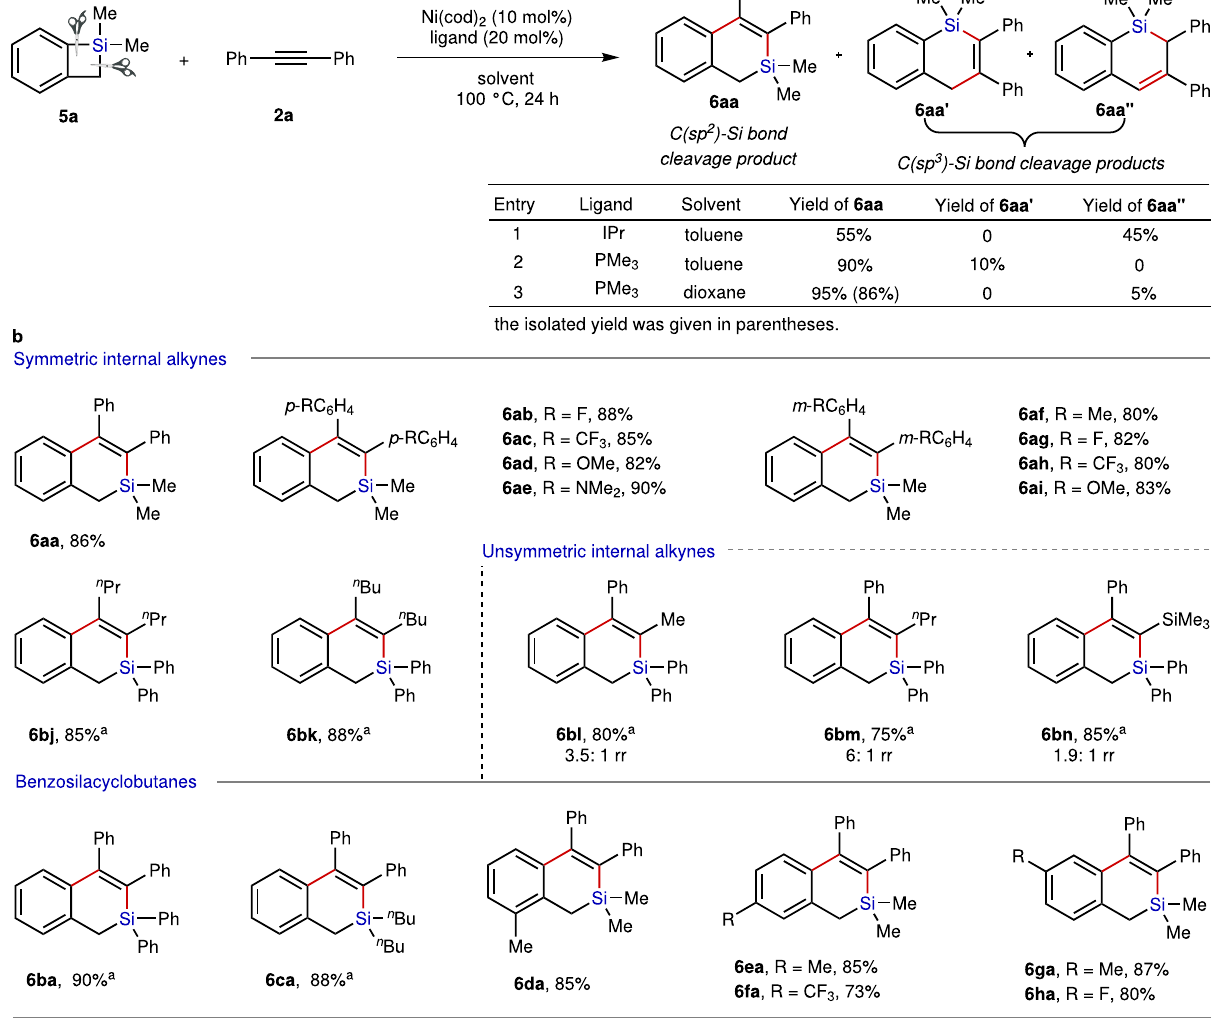
Fig. 2 Development of Ni-catalyzed cycloaddition of benzosilacyclobutenes with internal alkynes. a Condition optimization for the reaction of benzosilacyclobutene 5a with internal alkyne 2a . b Substrate scope for the Ni-catalyzed cycloaddition of benzosilacyclobutenes with internal alkynes under the optimized condition. Reaction condition: alkynes 2 (0.2 mmol) and benzosilacyclobutenes 5 (0.3 mmol, 1.5 equiv.), Ni(cod) 2 (5.8 mg, 0.02 mmol), PMe 3 (40 μ l, 1.0 M in THF, 0.04 mmol) and 1,4-dioxane (1.0 ml) at 100 °C for 24